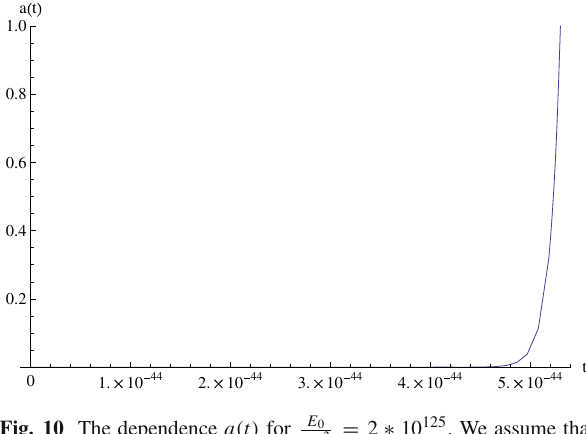
= 2 ∗ 10 125 . We assume that Fig. 10 The dependence a ( t ) for E 0 3 H 2 0 ρ (cid:21) ρ de m and the intermediate phase of oscillations is after the Planck epoch. Note that, for the above assumptions, inflation appears after the Planck epoch. The characteristic number of e-foldings of this inflation is equal to 53 here. The cosmological time t is given in seconds measurements of H ( z ) for galaxies, the Alcock–Paczy´nski test and the measurements